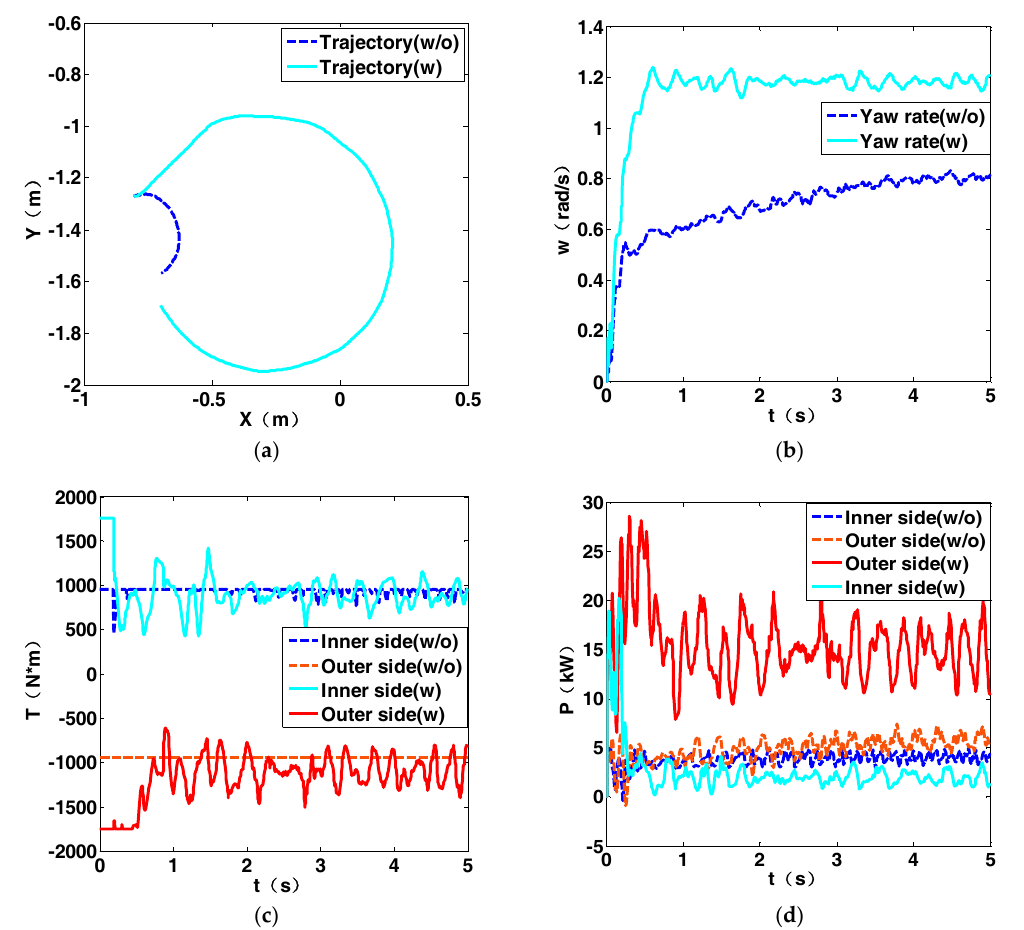
Figure 13. Simulation results of 0.5 B steering: ( a ) Trajectory; ( b ) Vehicle yaw rate; ( c ) Sprocket torque; ( d ) Sprocket power.